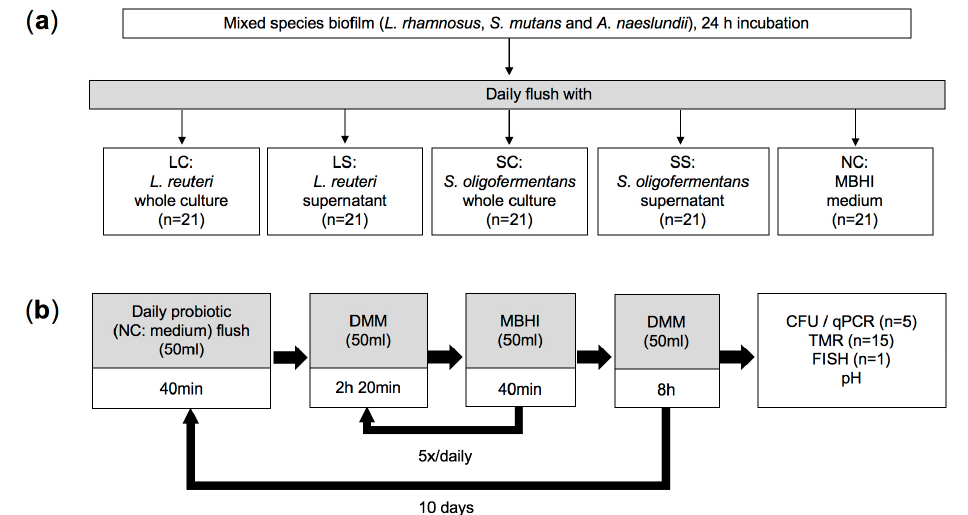
Figure 1. Study flow. ( a ) Multispecies biofilms were cultured for 24 h and then submitted to daily rinses with L. reuteri whole culture (LC), L. reuteri culture supernatant (LS), S. oligofermentans whole culture (SC), S. oligofermentans culture supernatant (SS) or fresh MBHI medium (NC). ( b ) The daily provision of modified Brain Heart Infusion (MBHI) broth and Defined Mucin Medium (DMM) was repeated over 10 days before submitting biofilms and specimens to further analysis. CFU: colony-forming units; qPCR: quantitative polymerase chain reaction; TMR: transverse microradiography; FISH: fluorescence in situ hybridization; n: sample